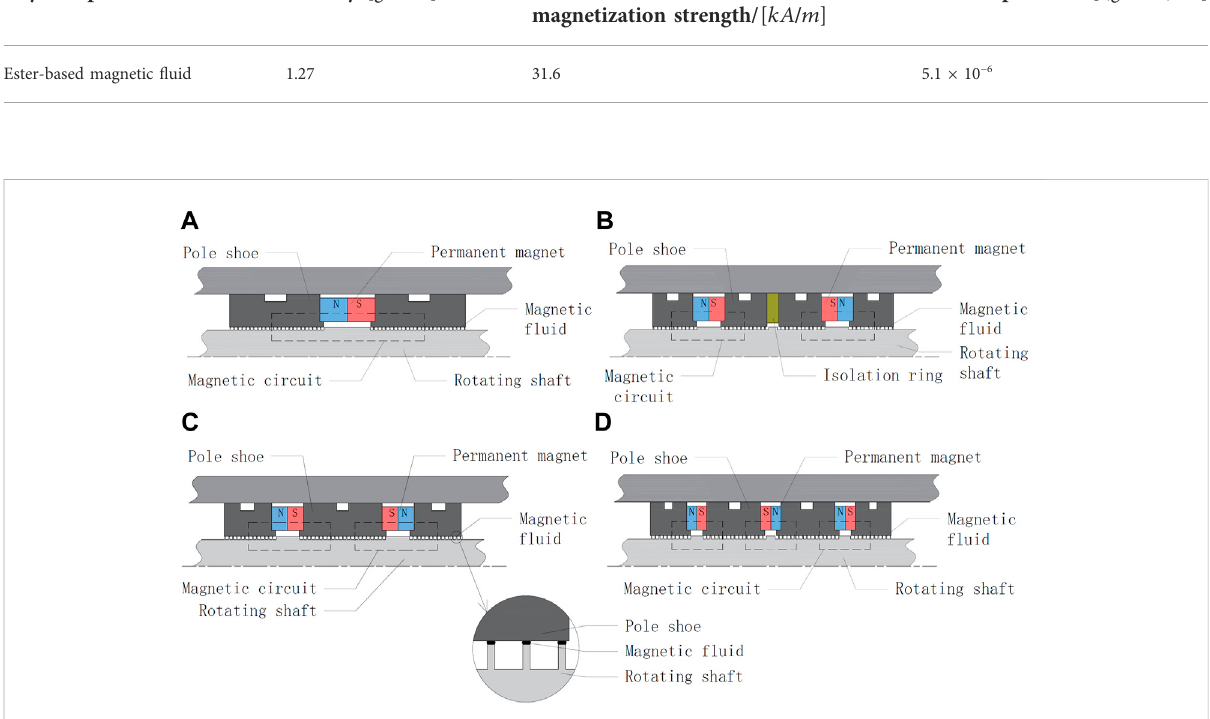
FIGURE 1 Structuraldesignofvacuummagnetic fl uidsealingdevice. (A) Singlemagnetmultistagesealingstructure. (B) Doublemagnetsplusisolationring multistage sealing structure. (C) Double magnets multistage sealing structure. (D) Three magnets multistage sealing